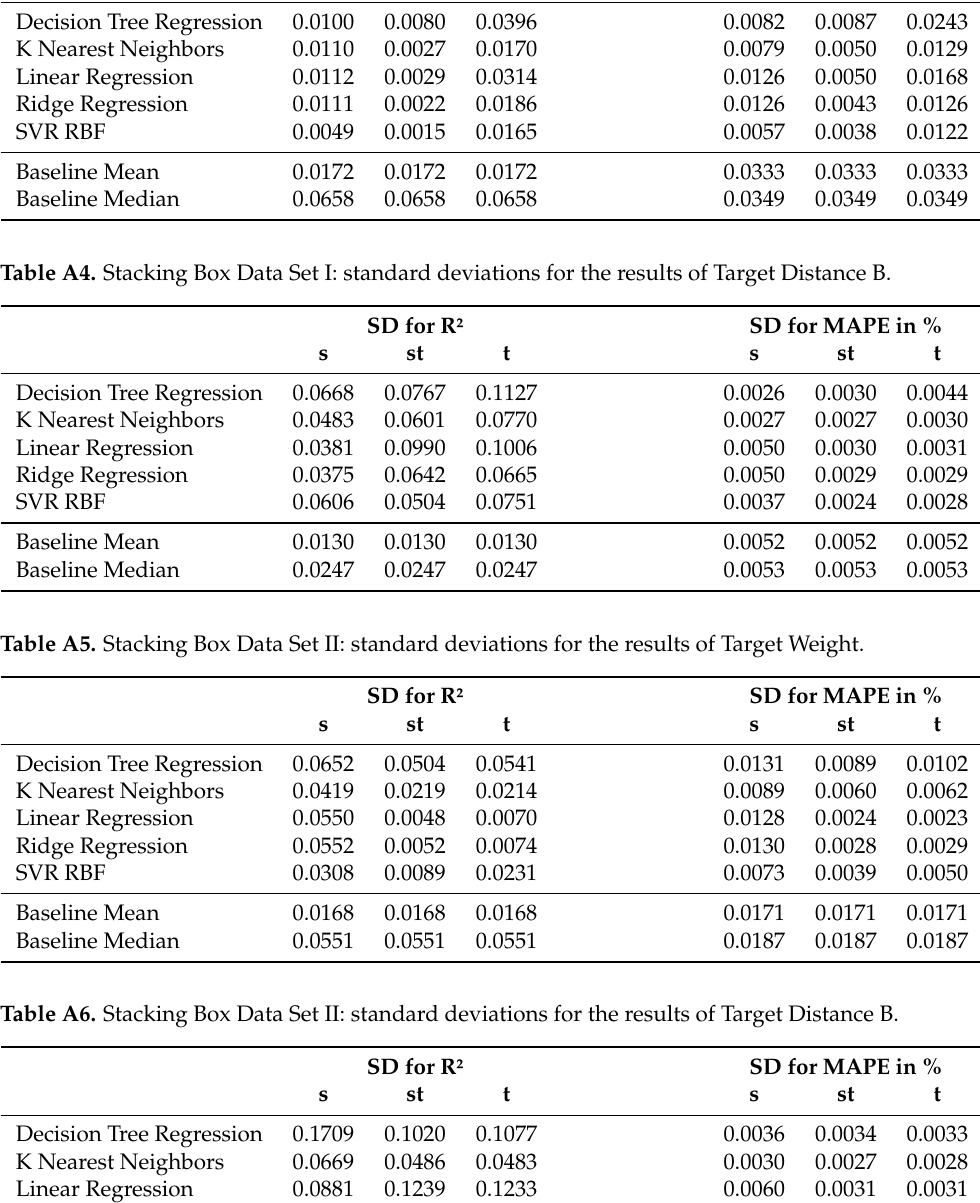
Table A3. Stacking Box Data Set I: standard deviations for the results of Target Weight. SD for R² SD for MAPE in %